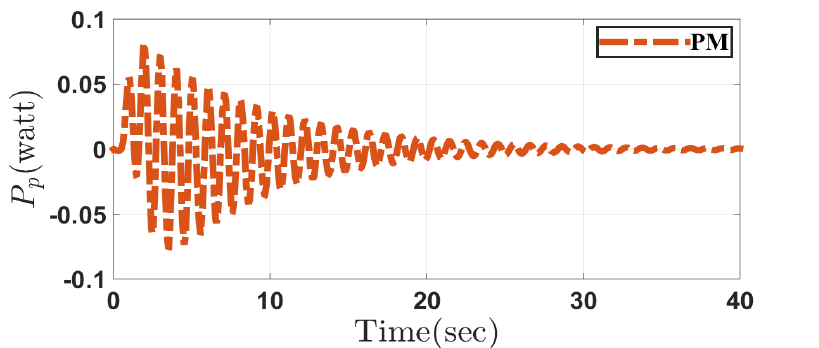
Figure 20. Input power of the movable mechanism in the proposed method (PM) in Case 2.